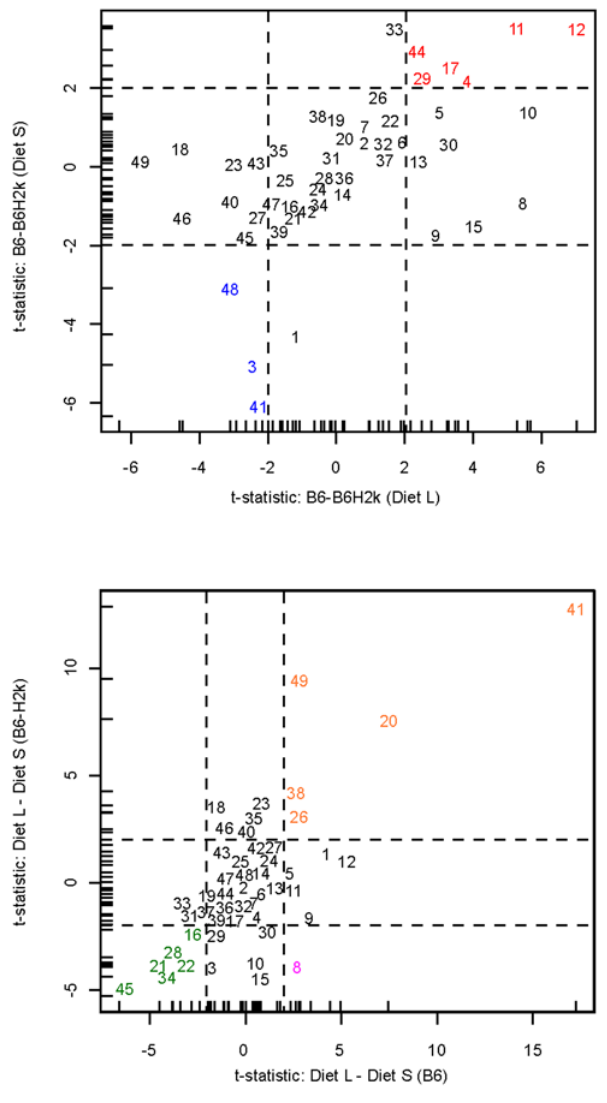
Figure 2. Comparison of t-statistics for within-diet MHC effects compared for two diets (top), and within-MHC Diet effects compared for two MHC types (bottom). Each number represents a compound, indexed in Table 3. Two separate test statistics are represented on horizontal and vertical axes. Horizontal and vertical dashed lines represent thresholds for statistical significance, so that the middle of central panel represents non-significance for both tests. Regarding the relative concentration of a certain compound, in the top panel, red color represents compounds where the concentration is higher in B6 than in B6-H2 k and blue color represents compounds where the concentration is higher in B6-H2 k than in B6 regardless of diet. In the bottom panel, orange color represents compounds where the concentration is higher in Diet L than in Diet S and green color represents compounds where the concentration is higher in Diet S than in Diet L regardless of MHC type. The pink color represents the single compound where the concentration is higher in Diet L under B6 MHC type, but is lower in Diet L under B6-H2 k MHC type.